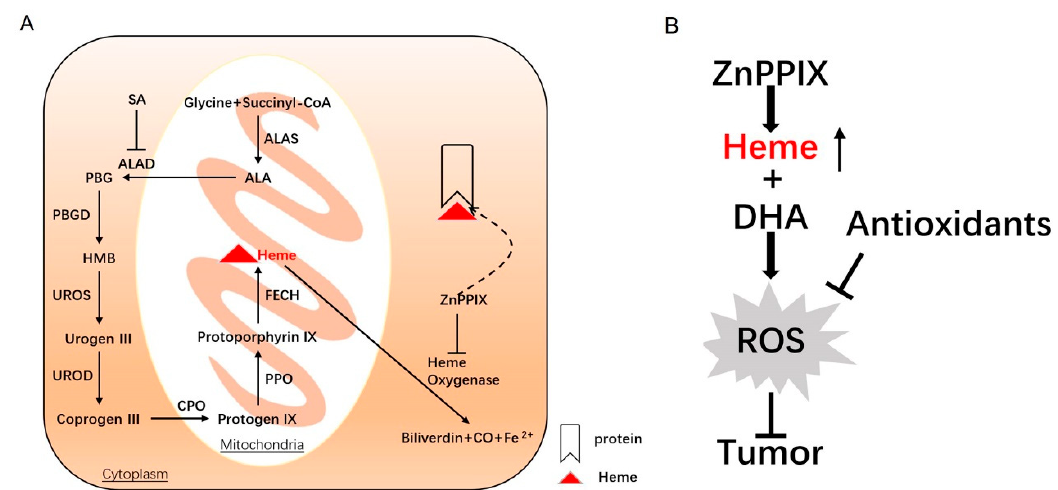
Figure 6. A schematic model illustrating the pathways underlying the synergistic anticancer action of ZnPPIX and DHA. ( A ) Heme synthesis and degradation. Heme synthesis starts in the mitochondrial matrix with the condensation of succinyl-CoA and glycine by ALAS to generate ALA. ALA leads to the final heme synthesis through a series of reactive processes, wherein ALAD is inhibited by SA. As an inhibitor of heme oxygenase, the heme analog ZnPPIX can reduce the degradation of heme, as well as compete with heme in protein binding, resulting in greatly heightened labile heme levels. ( B ) DHA-induced ROS generation is enhanced by ZnPPIX via heme elevation. The strengthened anti-cancer activity of DHA activity is mediated by ROS, as it can be counteracted by antioxidants that mitigate ROS accumulation.